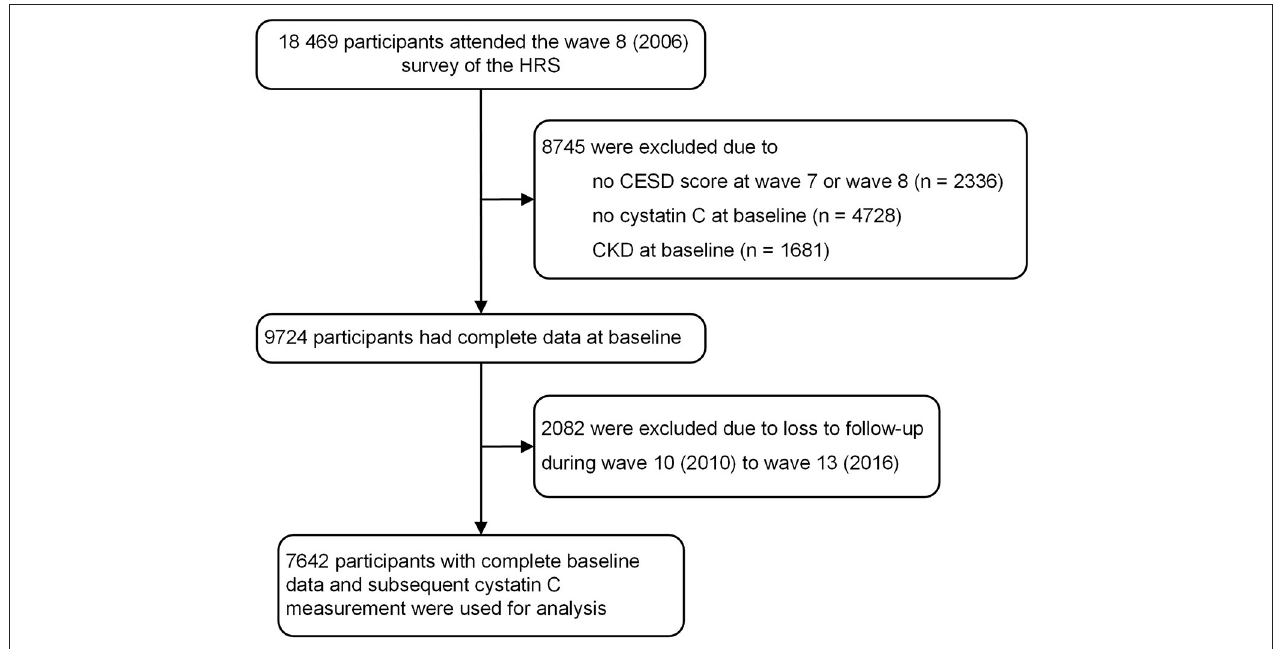
FIGURE 1 | Flow chart of participant selection for this study.